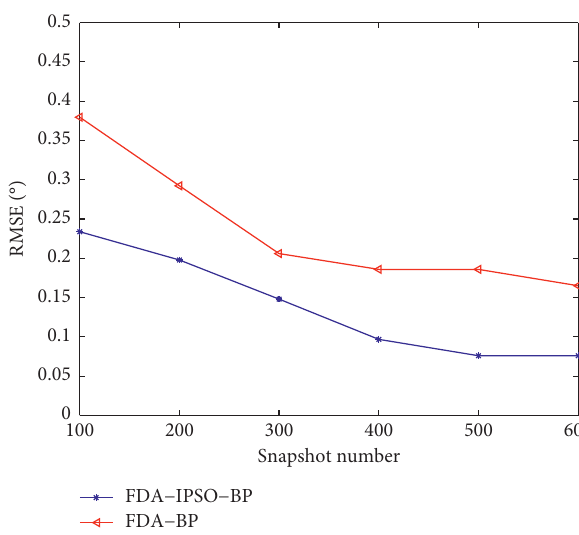
Figure 5: RMSE of azimuth estimation versus SNR. Figure 7: RMSE of azimuth estimation versus snapshot.